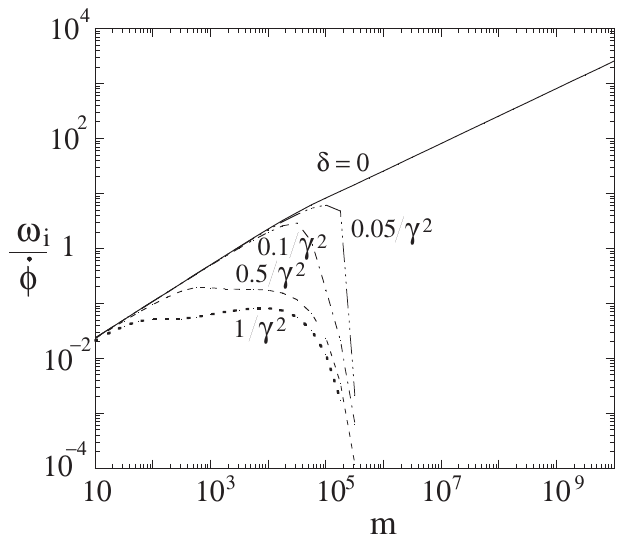
FIG. 2. Growth rates as a function of azimuthal mode m for (cid:5) (cid:2) 0 : 02 , (cid:2) (cid:2) 30 , and various energy spreads.